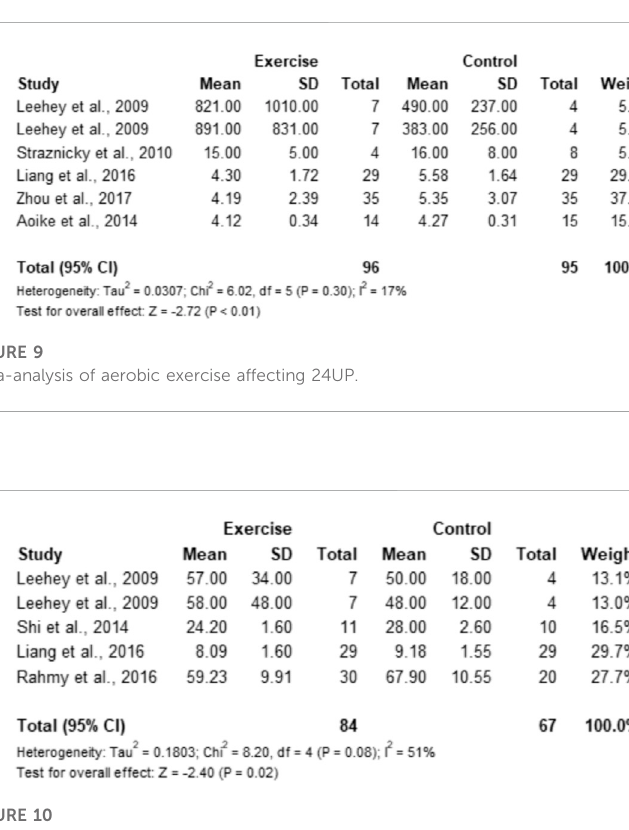
Meta-analysis of aerobic exercise affecting BUN.